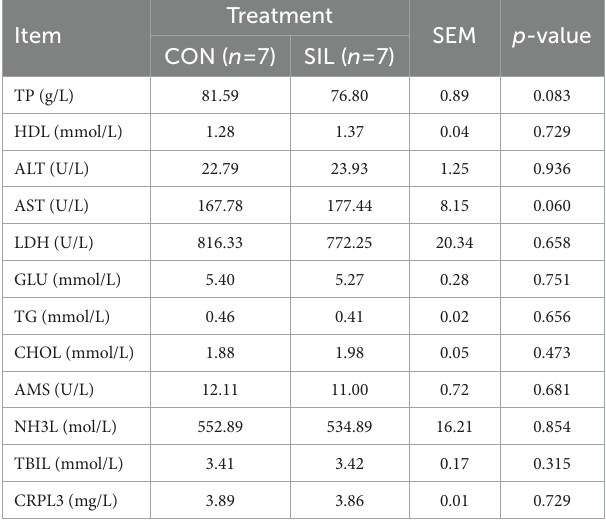
TABLE 3 Effect of silybum marianum meal as a replacement for soybean meal on serum biochemical parameters in lambs.